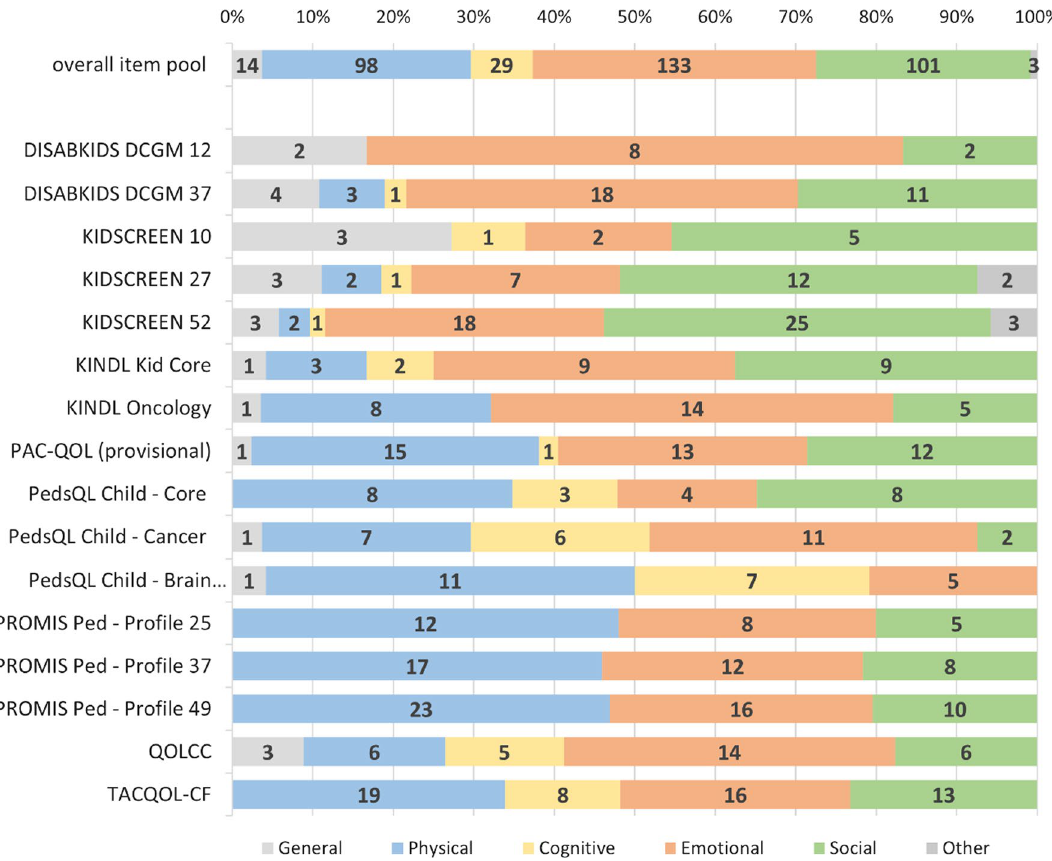
Fig. 2 Proportion and total number of items assessing the domains of health‑related quality of life within the overall item pool and within the different questionnaires (Numbers in bars indicate the total number of items; length of bars indicates the proportion, compared to the legend